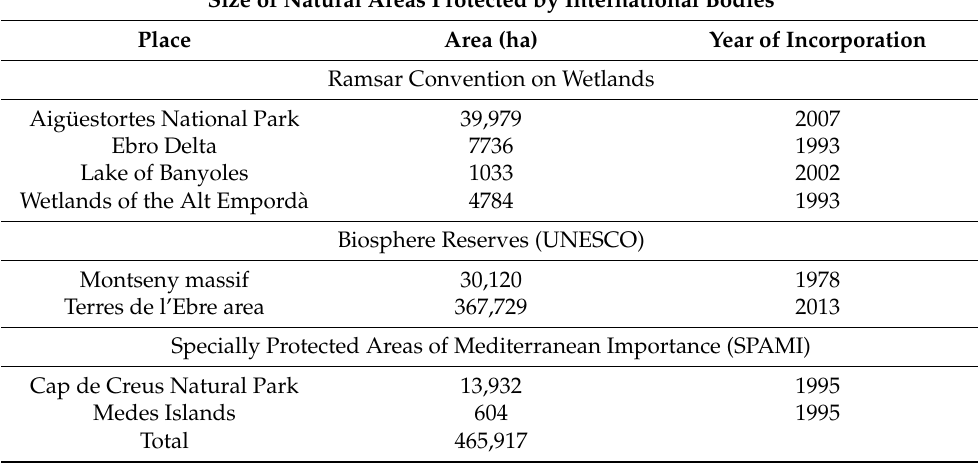
Table 16. Natural areas protected by international bodies. Source: Ministry of Agriculture and Fisheries, Food and the Environment of Spain (2017). Size of Natural Areas Protected by International Bodies Place Area (ha) Year of Incorporation Ramsar Convention on Wetlands Aigüestortes National Park 39,979 2007 Ebro Delta 7736 1993 Lake of Banyoles 1033 2002 Wetlands of the Alt Empord à 4784